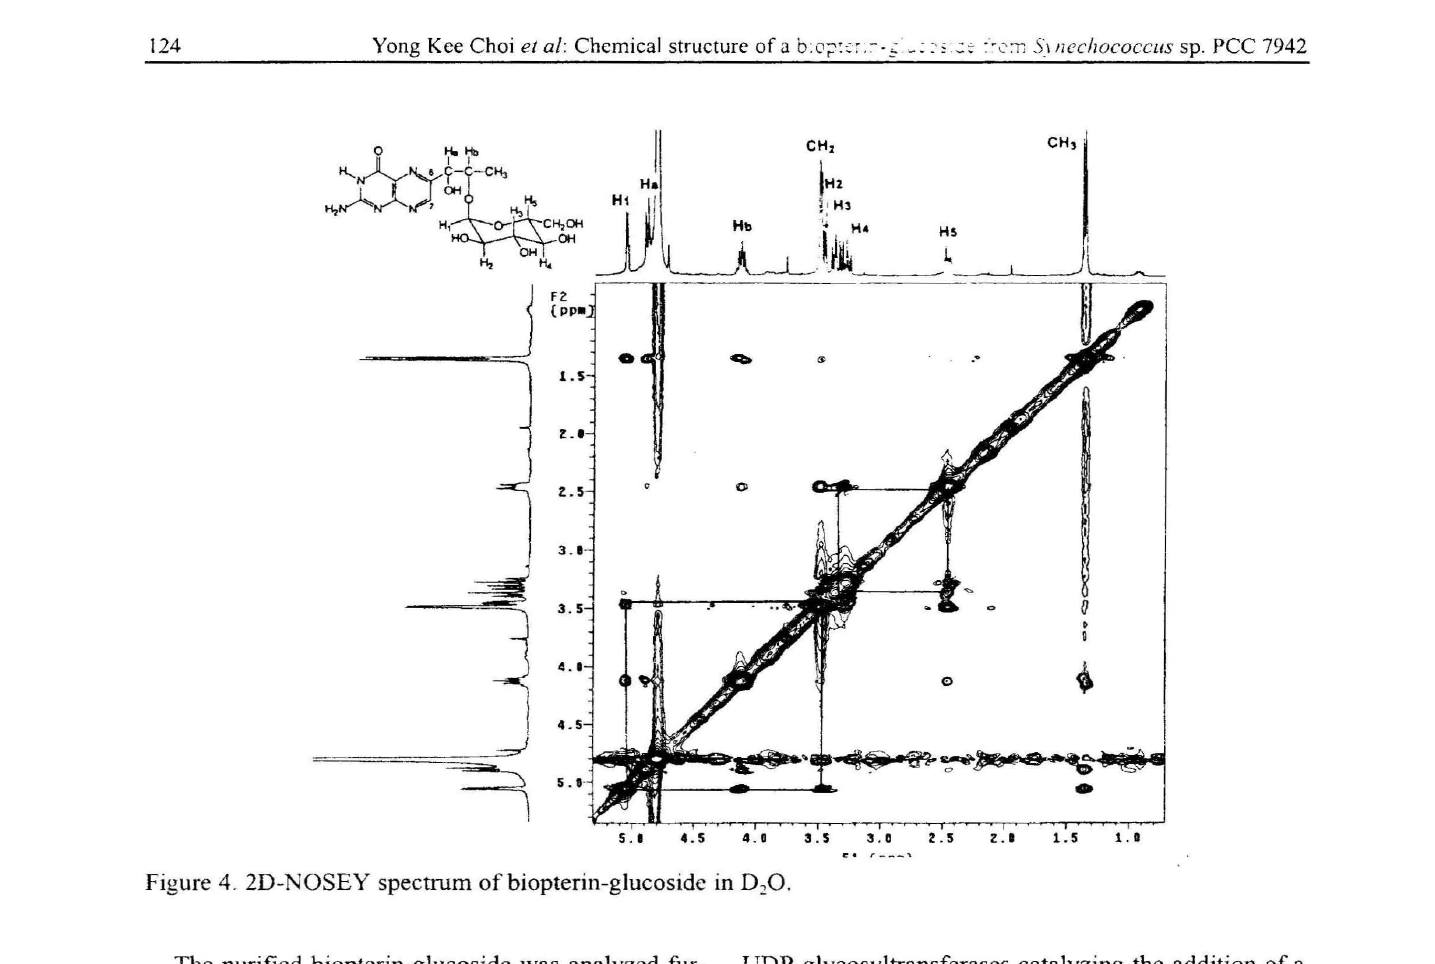
Figure 4. 2D-NOSEY spectrum of biopterin-glucoside in